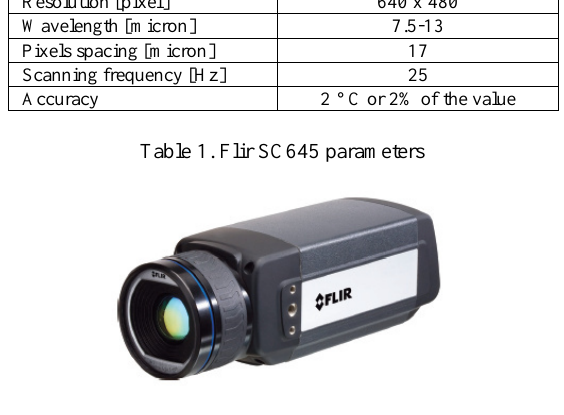
Figure 4. Thermometric camera Flir SC645